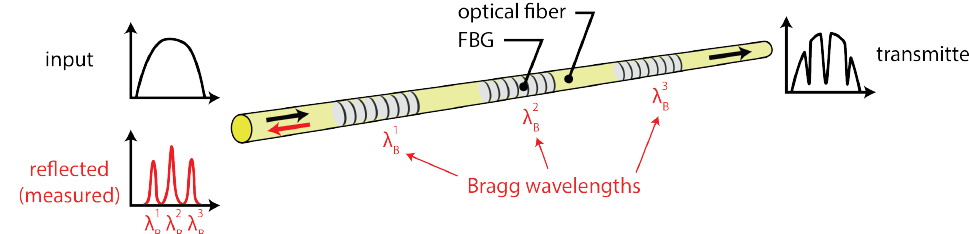
Figure 8. Operating Principle of